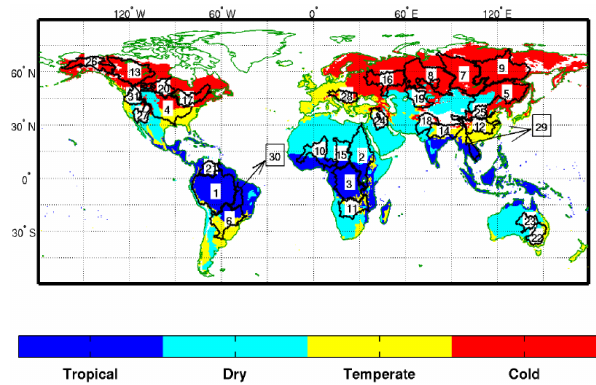
Figure 1. Locations of 31 globally distributed basins from the sim- ulated topological networks (STN-30p) with underlying Köppen– Geiger climate zones. Basin IDs and names are indicated in Table